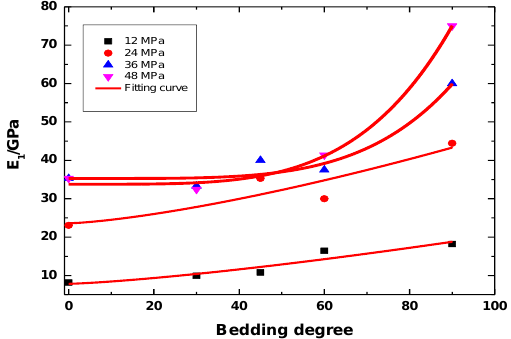
where a , b , and c are the fitting parameters, and ∂ is the bedding angle.